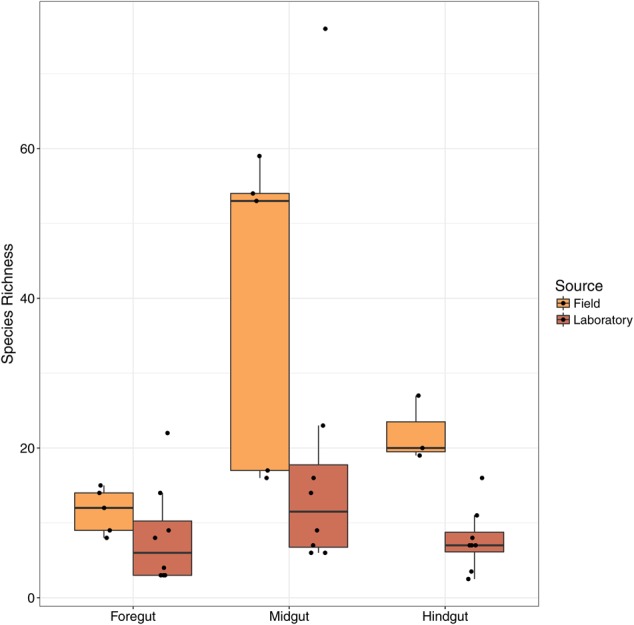
Species richness among gut regions in Mormon crickets. Note that field-caught and laboratory-raised animals differ in the DNA extraction method that was used.